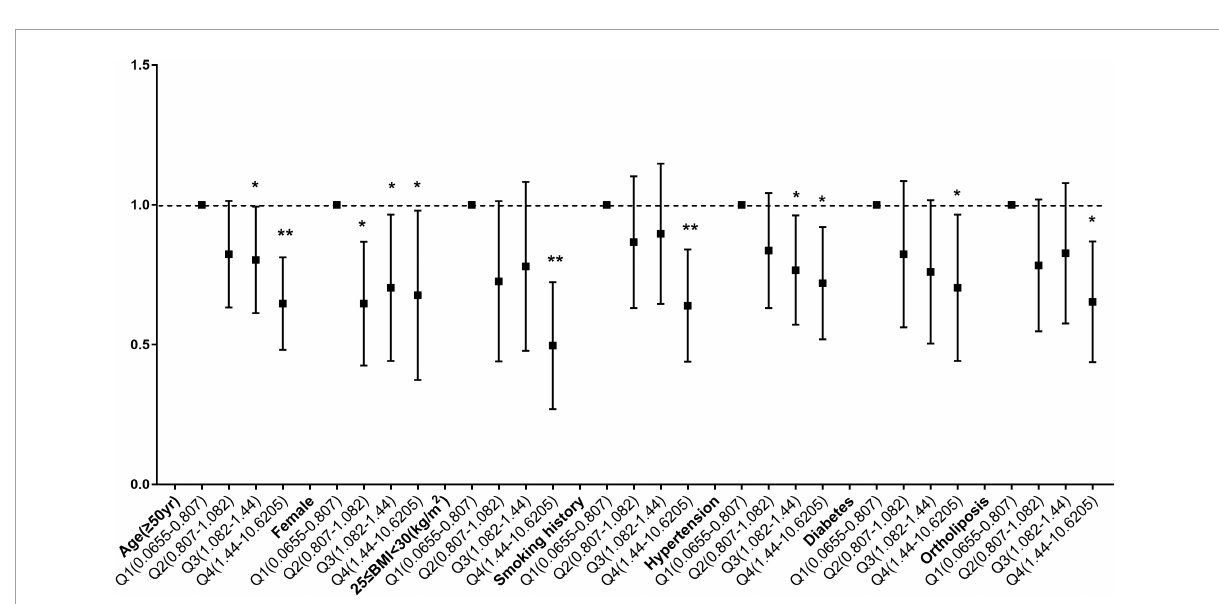
FIGURE4 Subgroup analysis of dose-related copper intake and myocardial infarction before matching. * p < 0.05, ** p < 0.01.